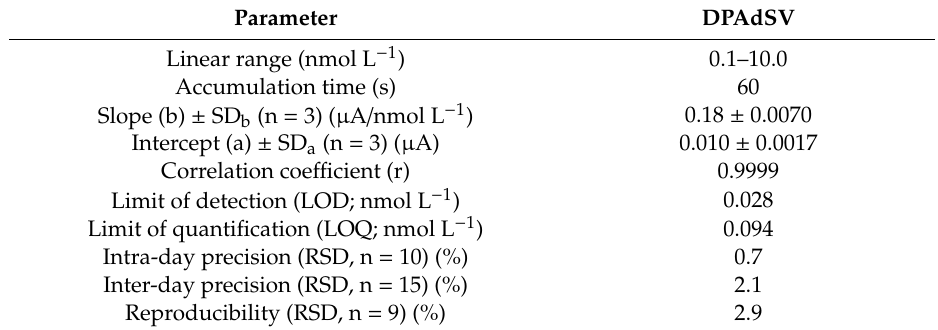
LOD = 3SD a / b and LOQ = 3SD a / b [41]; RSD: relative standard deviation for a DF concentration of 10.0 nmol L − 1